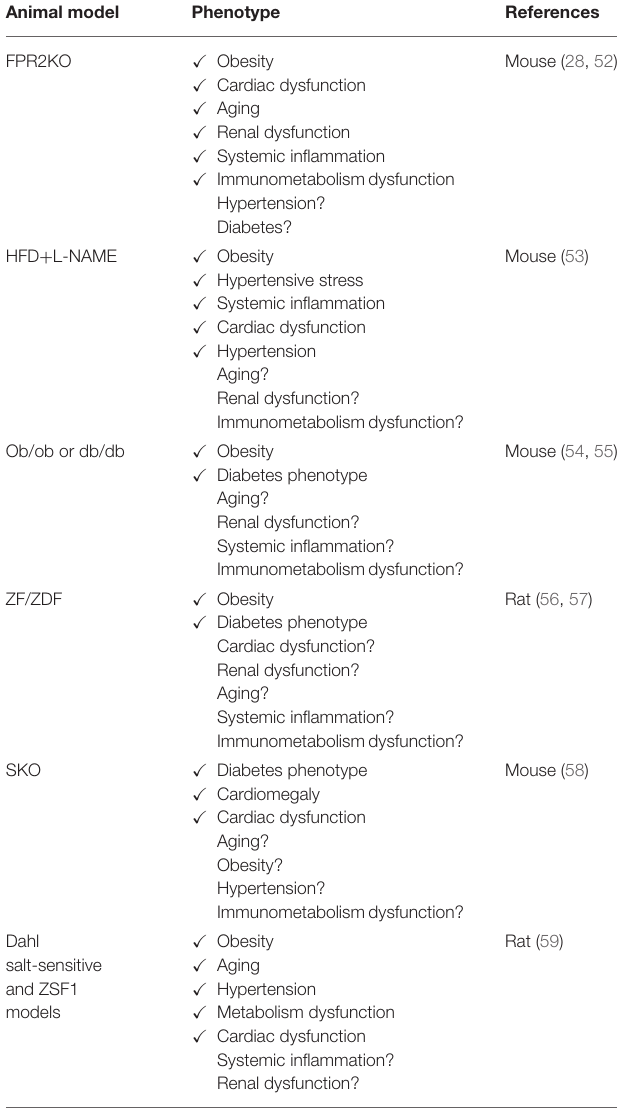
TABLE 1 | List of current heart failure with preserved ejection fraction (HFpEF) animal models with coexistence of metabolic